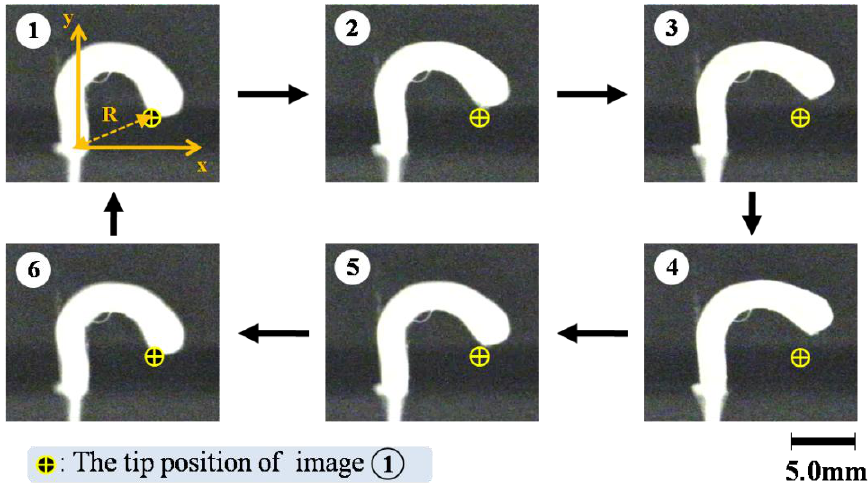
Figure 7. Trajectory of the tip of the gel relative to its attachment position during pH